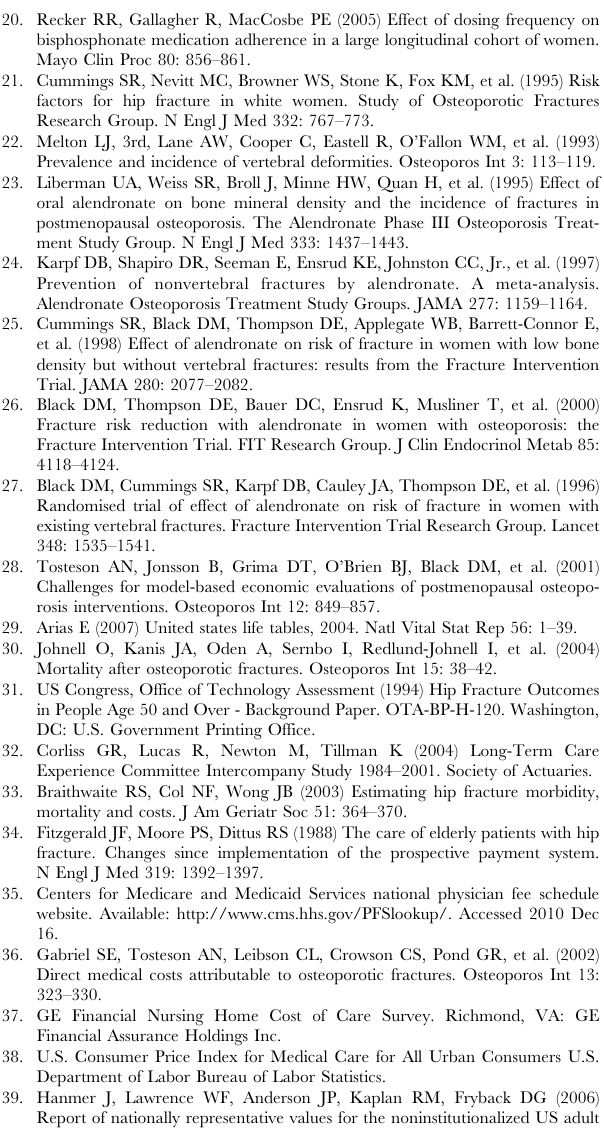
Table S1 Key Model Parameter